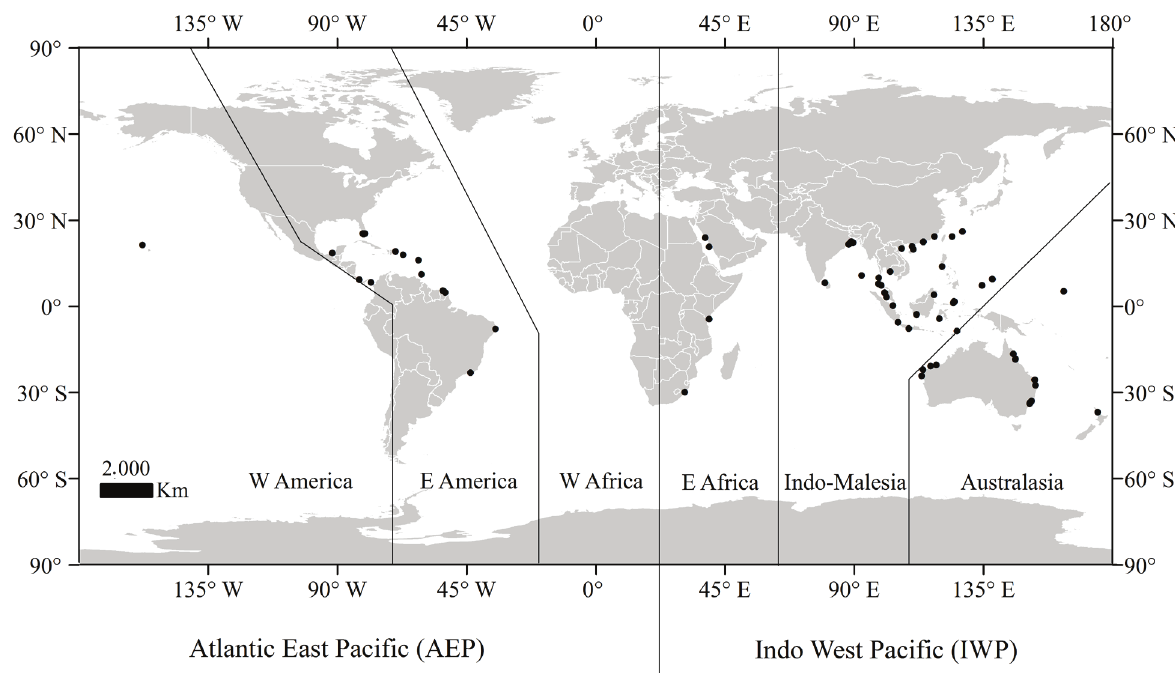
Figure 1 - Map (Aitoff projection) of the geographical distribution of the compiled articles (black circles) by Biogeographical Region and Sub-Region (according to Duke